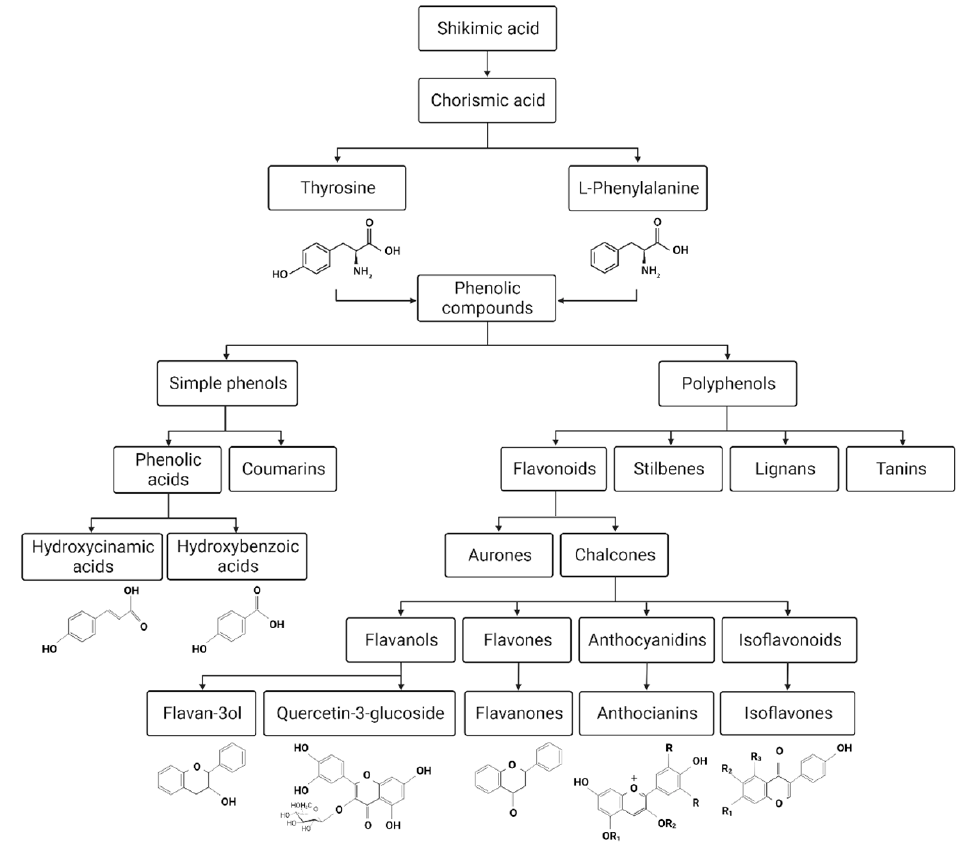
Figure 4. Phenolic compounds pathway in peppers ( Capsicum spp.). Chemical structure of the most abundant phenolic compounds in Capsicum fruits (from their precursors).